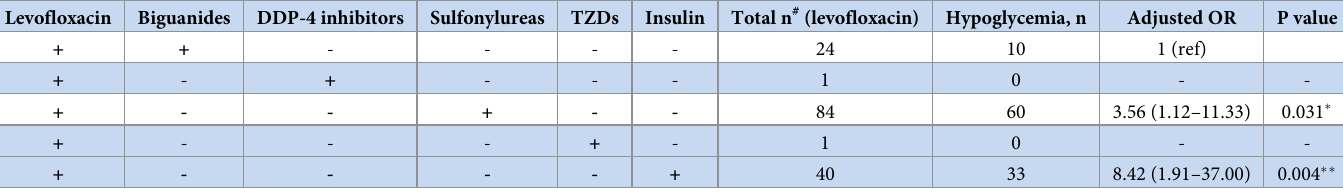
Table 5. Joint effect analyses of oral levofloxacin and antidiabetic drugs on the risk for hypoglycemic emergency.